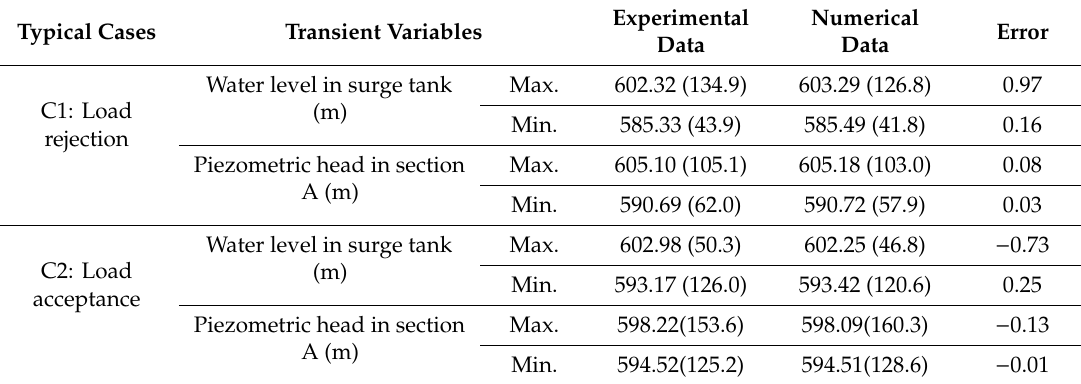
Figure 10. Time histories of the water level in the surge tank and piezometric head in section A under C2: ( a ) water level in surge tank; ( b ) piezometric head at section A.